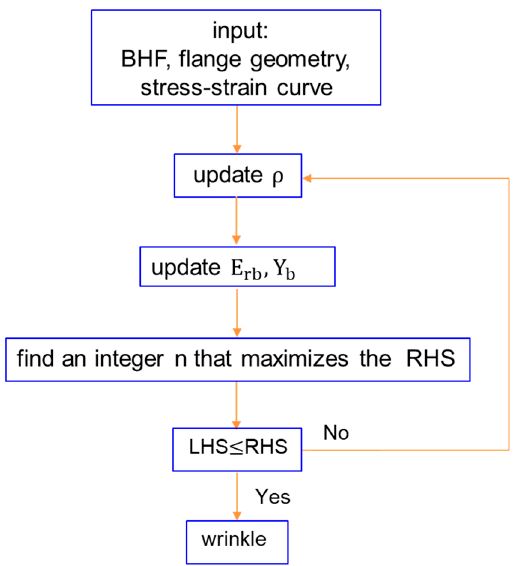
Figure 9. A flow chart showing the implementation procedure of the wrinkling model proposed in this work.